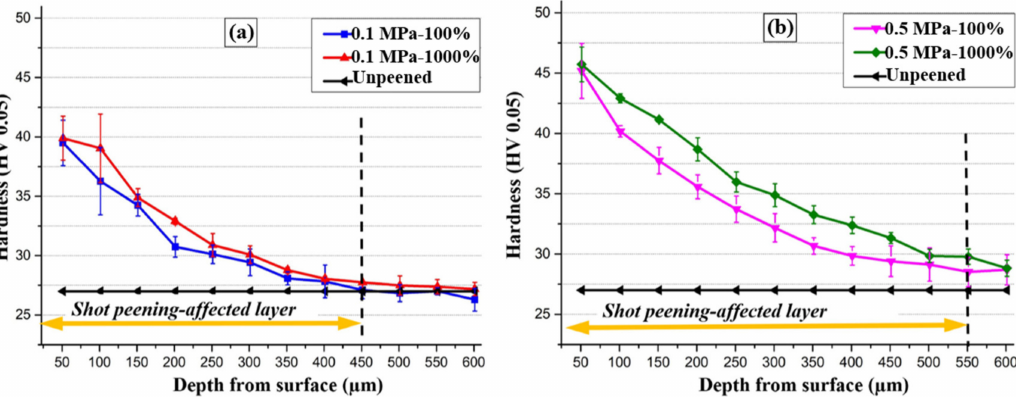
Figure 7. Change in microhardness along depth direction under different coverage rates and peening pressures: ( a ) 0.1 MPa; ( b ) 0.5 MPa [57].